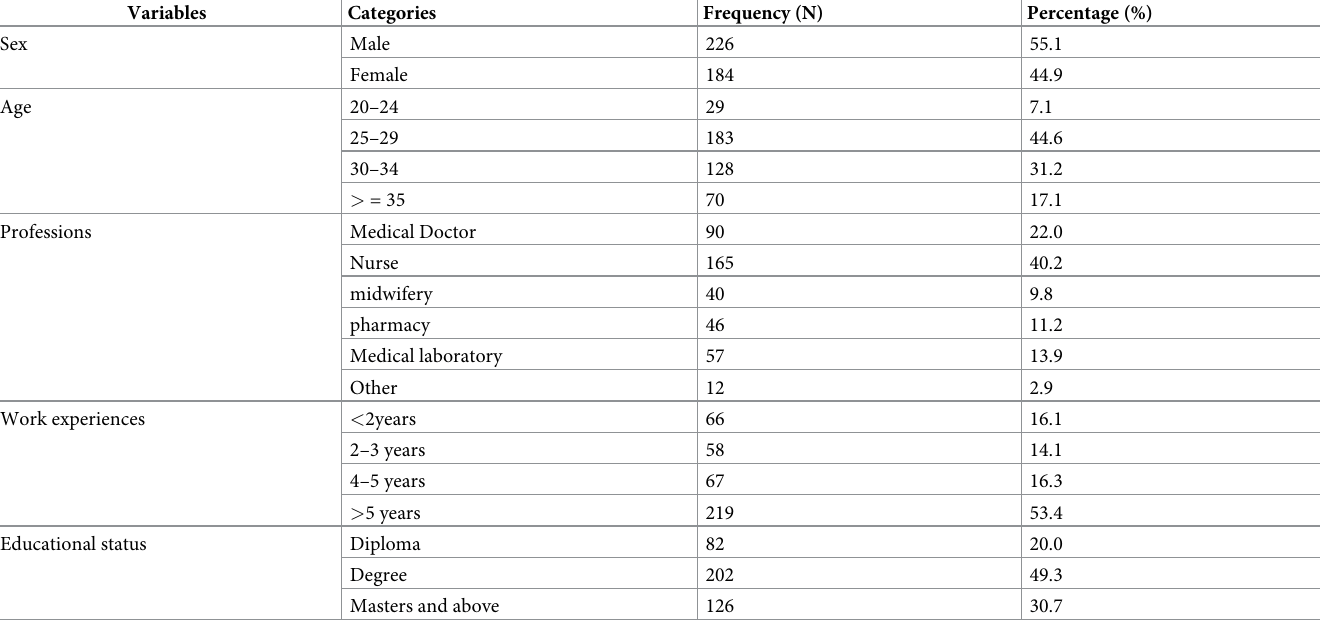
Table 1. Socio-demographic characteristics of health professionals working in all private hospitals Amhara region 2021 (N = 410).